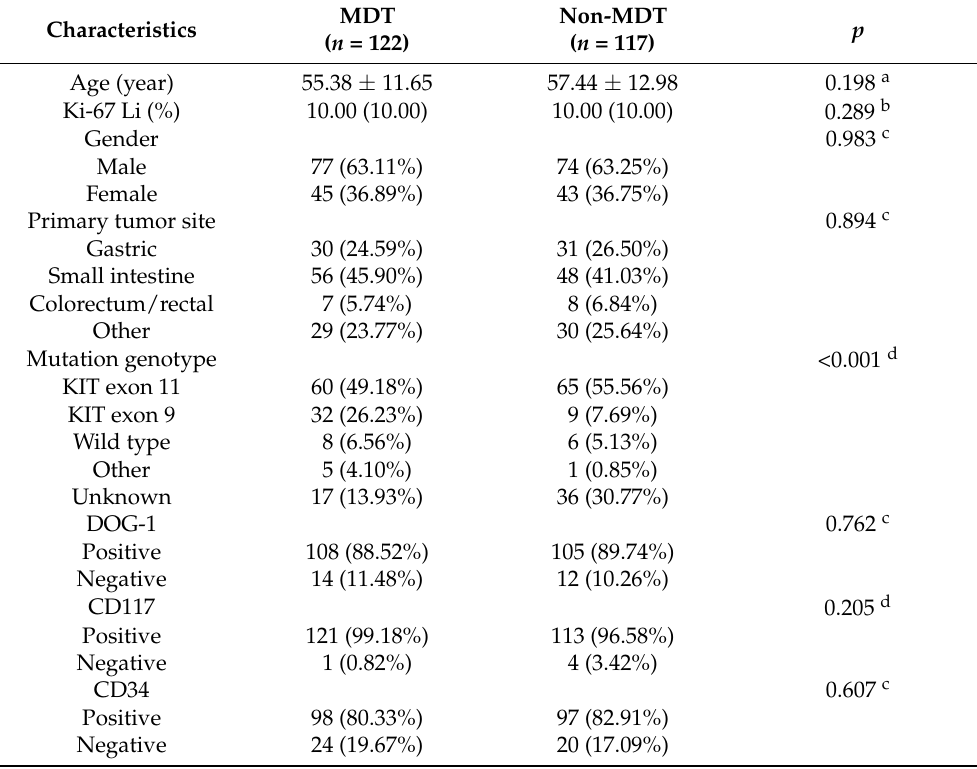
Table 1. Baseline clinical characteristics of patients with GISTs who received and did not receive MDT discussion